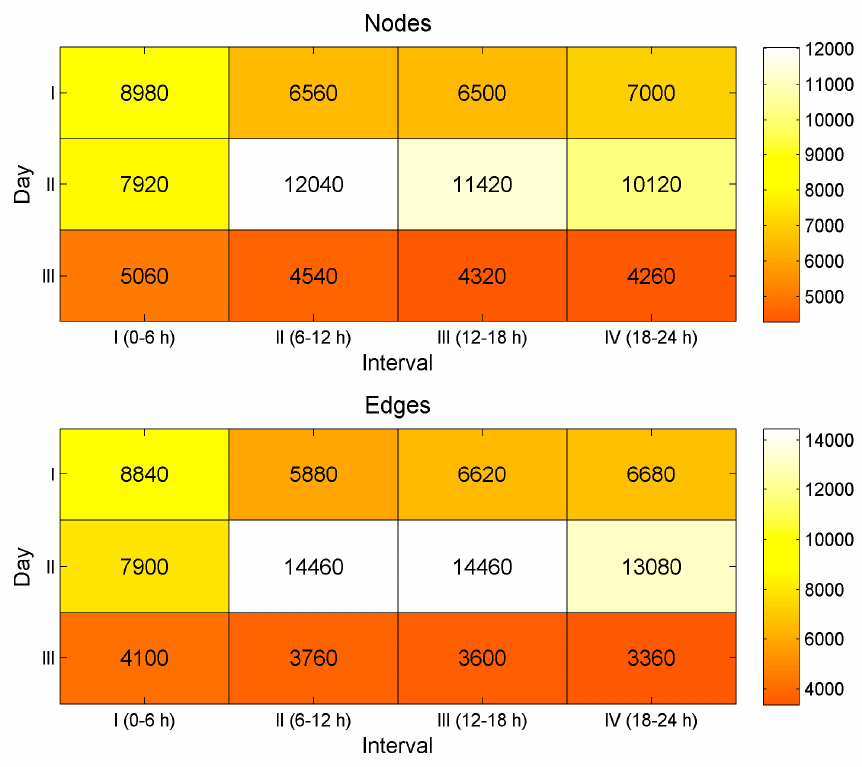
Figure 4. Summary of the number of nodes and edges in the Twitter dataset.